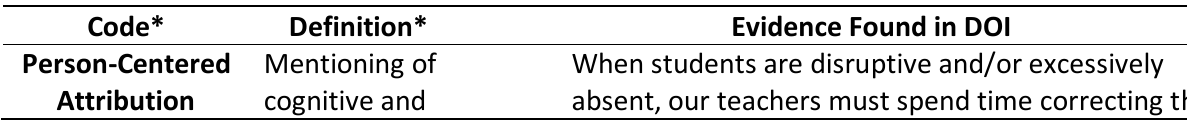
Table 1: Macro-Level Policy Coding